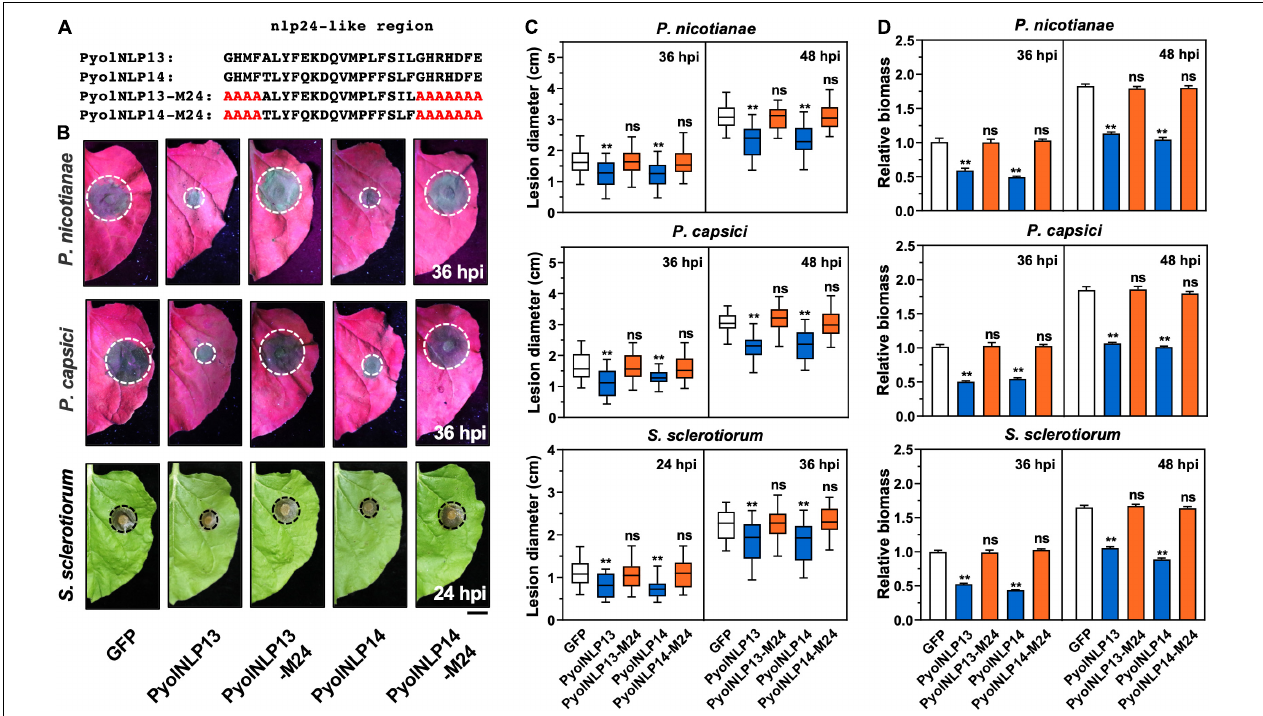
FIGURE 6 | Non-cytotoxic PyolNLPs suppress pathogens infection in N. benthamiana in a nlp24-dependent manner. (A) Schematic representation of nlp24-like regions in PyolNLP13, PyolNLP13-M24, PyolNLP14 and PyolNLP14-M24 with introduced alanine substitutions. (B) Infection phenotypes of infiltrated N. benthamiana leaves expressing GFP, PyolNLP13, PyolNLP13-M24, PyolNLP14 or PyolNLP14-M24, and followed by the inoculation of P. capsici , P. nicotianae or S. sclerotiorum . Photos were taken at 24 and 36 hpi (Scale bar, 1 cm). GFP was used as a negative control. (C) Lesion diameters were measured using ImageJ. Data were analyzed from at least 40 biological replicates. Error bar represents mean ± SD. (D) Relative biomass was determined by qPCR. Expression levels of P. nicotianae, P. capsici and S. sclerotiorum Actin were determined by qPCR using N. benthamiana EF1 α as reference. Error bar represents mean ± SD ( n = 3). Data were analyzed by Median-edition Levene’s test to determine the homogeneity of variance across groups, and then analyzed by one-way ANOVA with post-hoc Tukey’s range test for groups with equal variance, or Kruskal-Wallis test analysis for groups with unequal variance (ns, no significant difference; ** P < 0.01). All experiments were repeated at least three